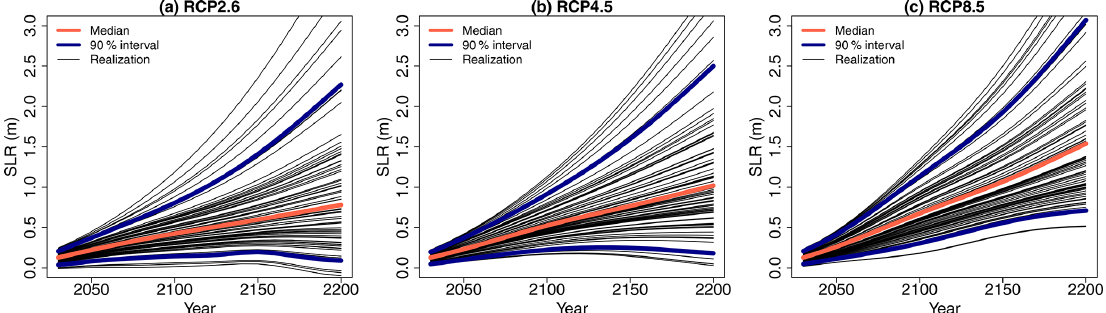
Figure 4. Future projection of regional SLR for 3 different RCP scenarios. The red line indicates the median, and the blue lines indicate the bounds of the 90% confidence interval provided by Kopp et al. (2014). The different black lines correspond to a subset of 75 randomly generated time series using the procedure described in Sect. 2.3.